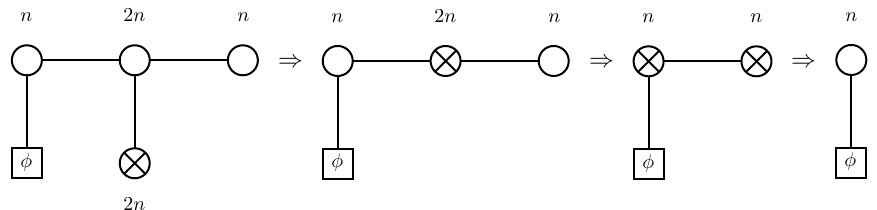
Figure 9 . Integrating out the small fermions yields an e(cid:11)ective matrix integral for a new system with the matrix structure depicted here. One can keep going until one is left with a single node coupled to the spinon. The structure of the latter node is akin to the one for an SL(2) spin chain. The manipulations carried out here are reminiscent of the dualization procedure for super spin